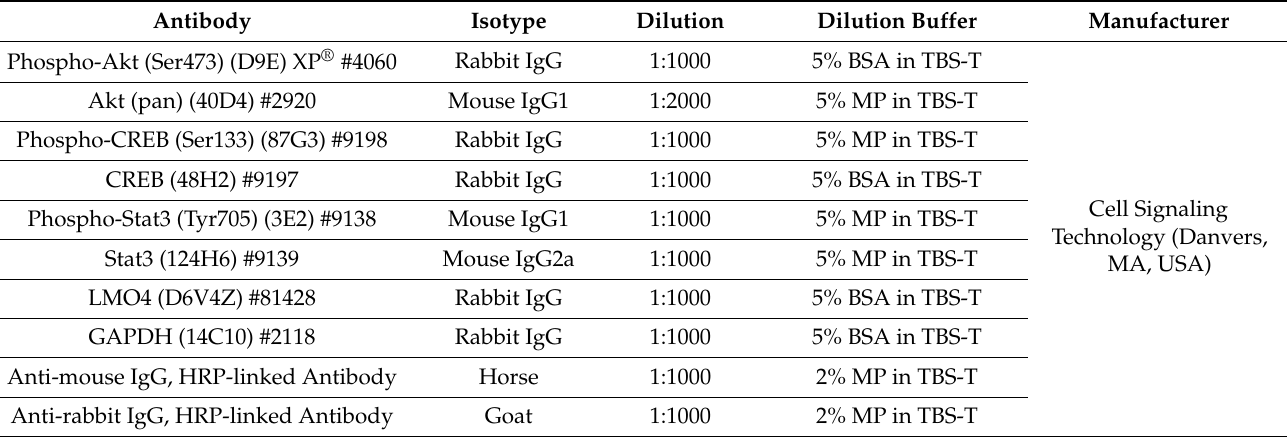
Table 2. Antibodies used for Western